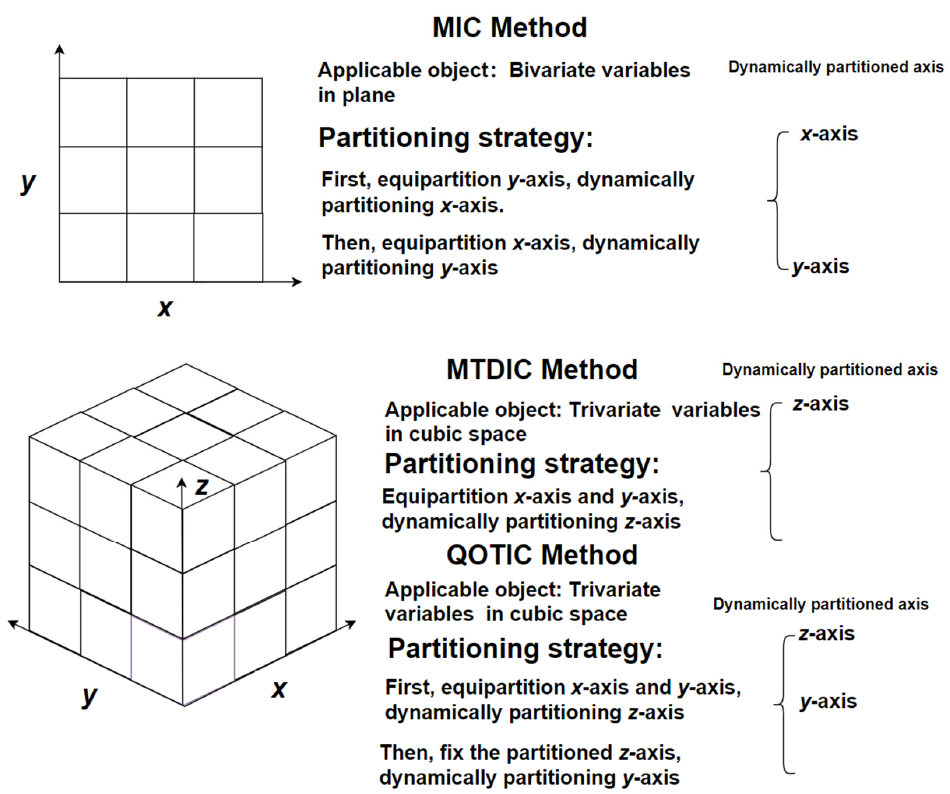
Figure 2. Partition strategies of bivariate variables and trivariate ones.